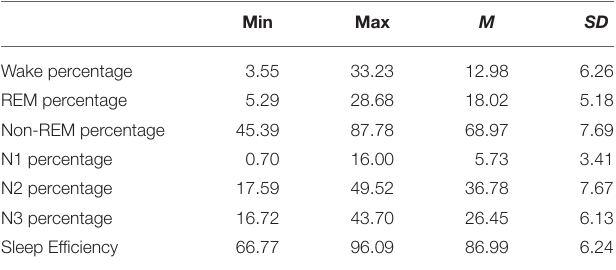
TABLE 1 | Overview of sleep parameters (in minutes) averaged over both nights ( n = 40). Min Max M SD TIB 257.18 597.12 466.89 80.14 TST 226.40 549.00 405.16 71.30 TWT 15.09 175.70 61.59 33.66 SOL 0.00 147.32 REM SOL 6.00 213.00